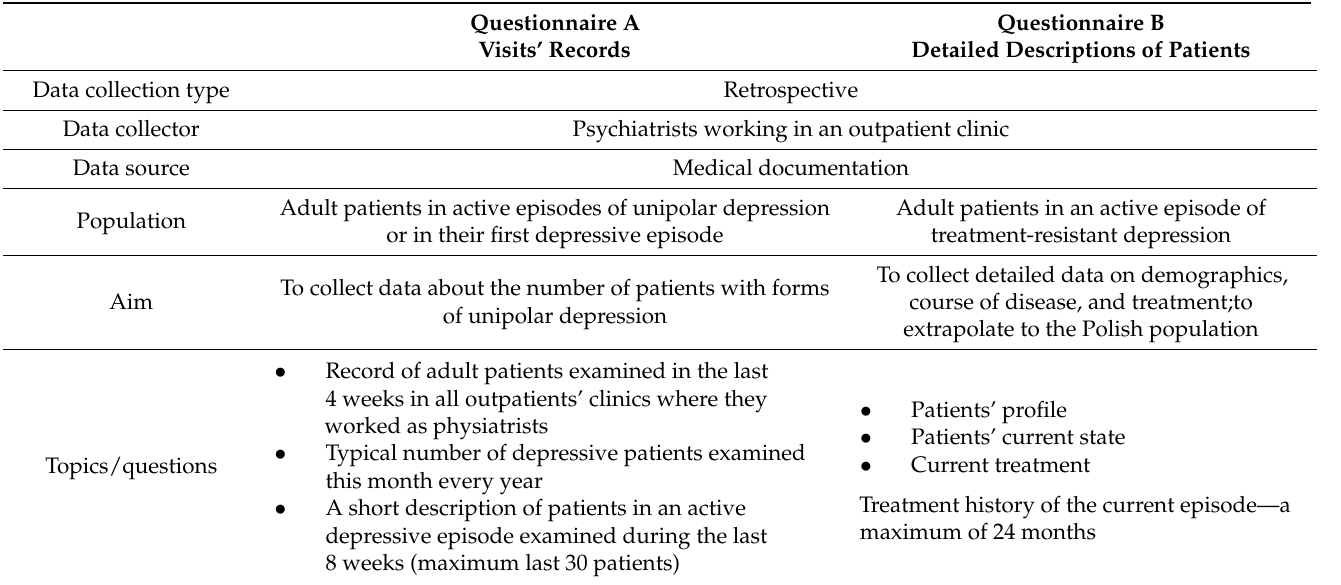
Table 1. Data collection methods for Questionnaires A and